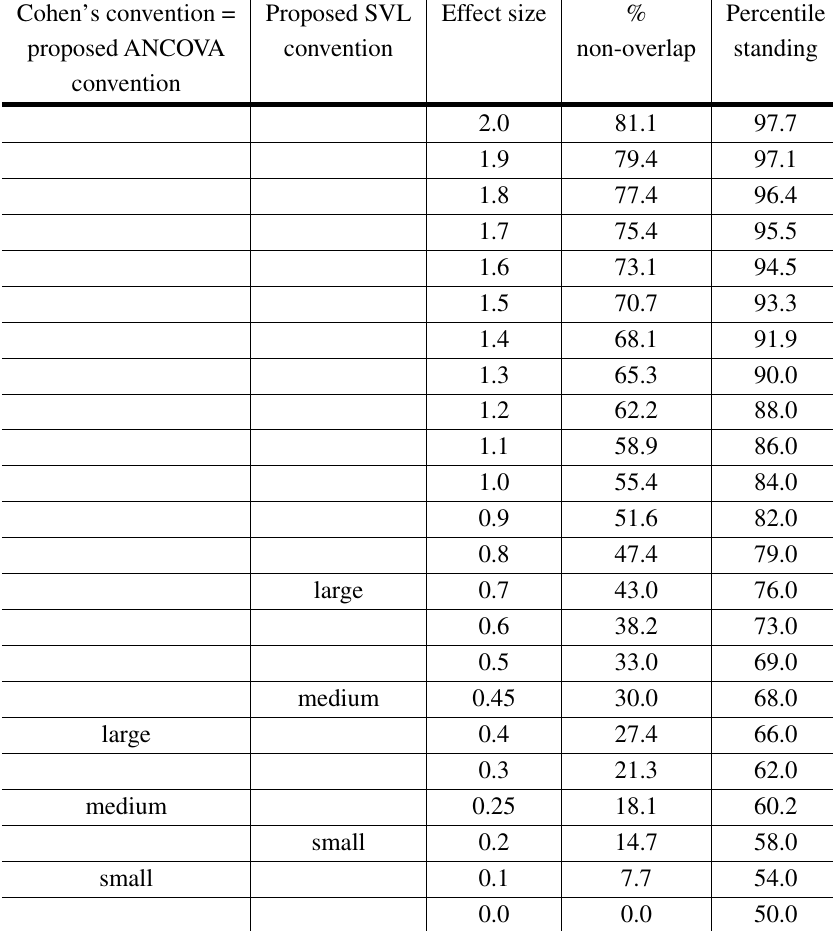
InterpretationsofEffectSizevalues. Percentnon-overlapistheamountofoverlapbetween two groups: An Effect Size = 0.0 indicates that the distribution of the female measurement data totally overlaps that for the males, i.e., 100% overlap or 0% non-overlap. Percentile standing: The percentage of the female population data that the upper half of the male population data exceeds, i.e., Effect Size = 0.0 indicates that the mean of the female data is at the 50 th percentile of the male data and an Effect Size = 0.8 indicates that the mean of the females is at the 79 th percentile of the male